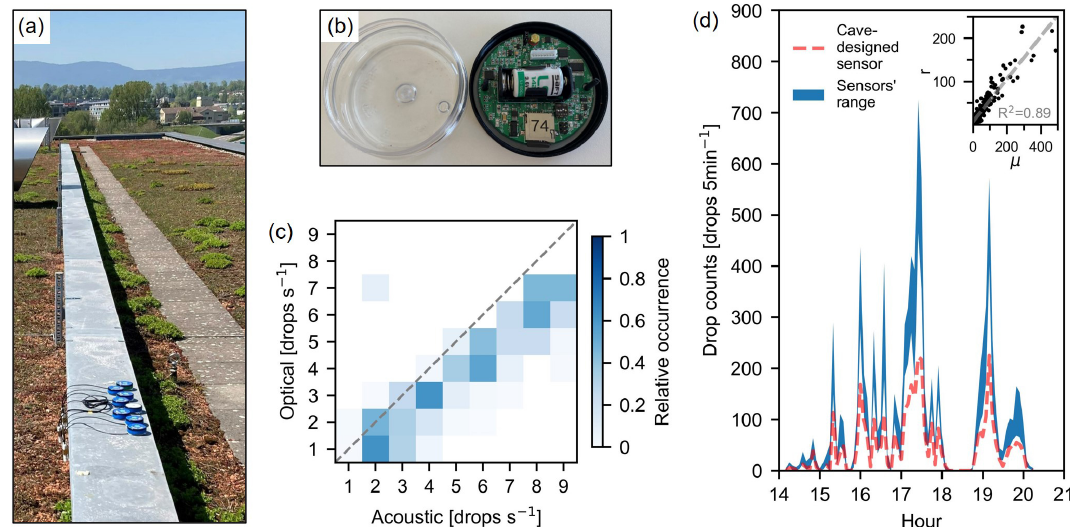
Figure 1. (a) The rooftop experiment with eight acoustic sensors placed closely together. (b) A close-up of an acoustic sensor. (c) Laboratory dripping experiment results; the occurrence of the acoustic sensors’ records is in relation to the optical sensor’s records. (d) Raindrops recorded by the seven high-sensitivity acoustic sensors on the roof of the University of Lausanne (shown in panel a ) during a rainfall event on 30 April 2022 (blue area indicates maximum–minimum records). The dashed red line depicts the records from a single low-sensitivity (cave-designed) sensor. Inset shows the sensor range ( r ) in relation to mean drop counts ( µ ) with a linear fit (gray